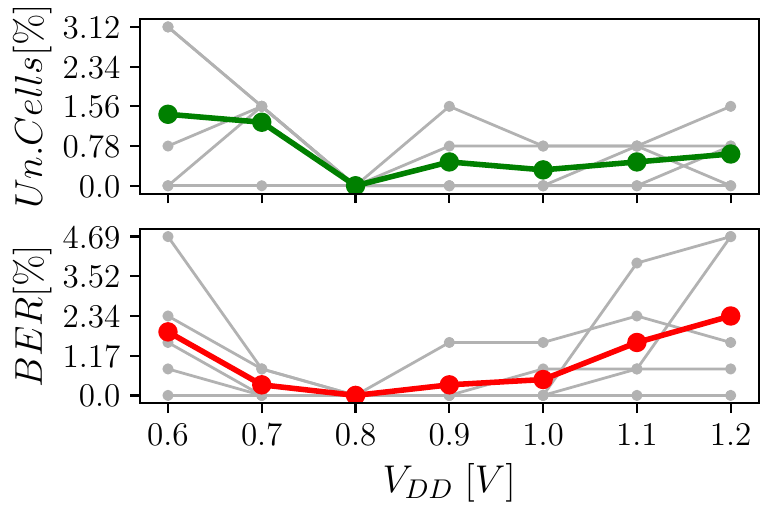
Figure 9. Unstable Cells and BER in percentage under voltage variations over 5 chips, average trend highlighted in green and red